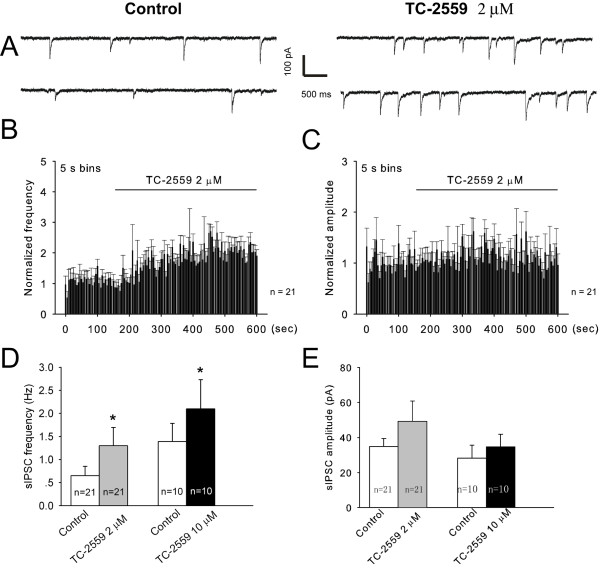
TC-2559 enhanced the frequency of sIPSCs in the superficial dorsal horn of the spinal cord slices. A, Whole-cell Patch-clamp recording of sIPSCs in a substantia gelatinosa (SG) neuron in the presence of 15 μM DNQX before and during bath application of 2 μM TC-2559. The holding voltage is -70 mV. B-C, Normalized rate histogram showing the sIPSC frequency (B) and amplitude (C) before and during bath application of 2 μM TC-2559. D-E, Application of TC-2559 (2, 10 μM) significantly enhanced the frequency of sIPSCs, but not the amplitude. *P < 0.05 (paired t test).